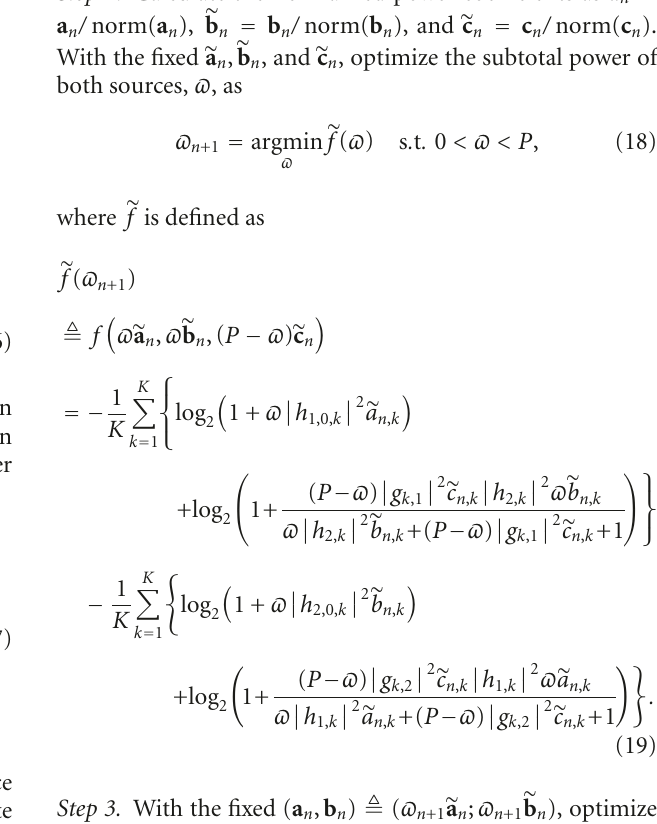
Algorithm 1 (iterative optimization of the nonconvex prob- lem